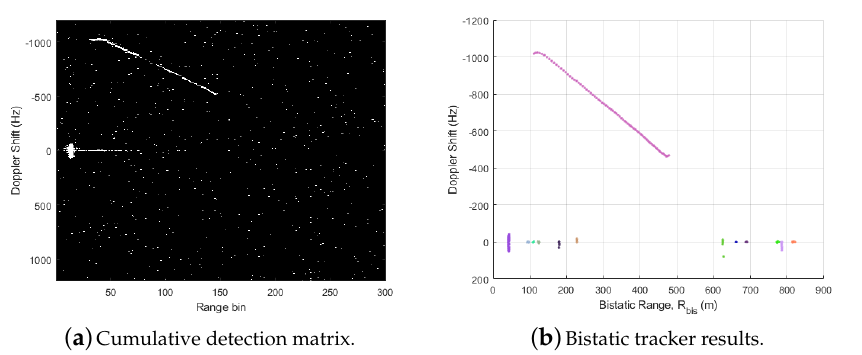
Figure 14. Detection and tracking outputs of the first step without target motion compensation of the proposed scheme.